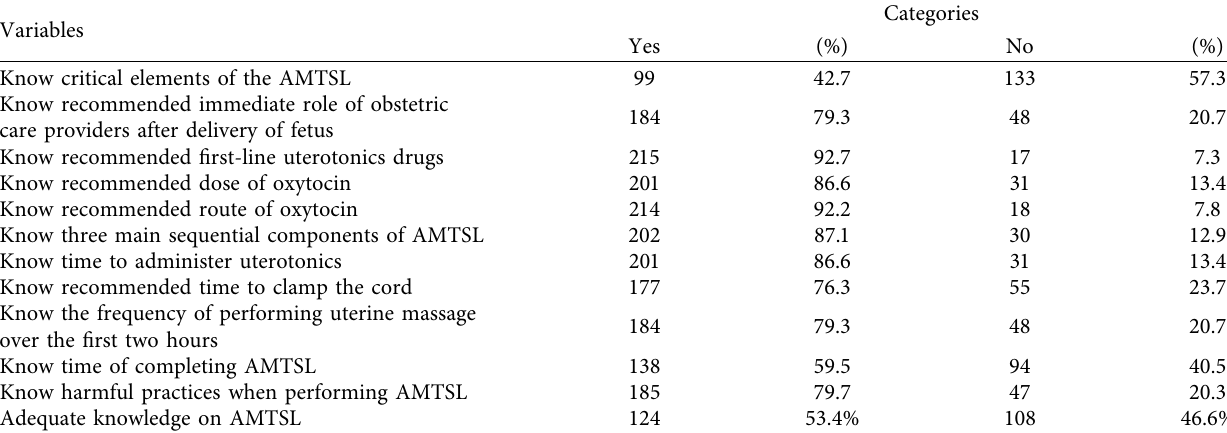
Table 5: Knowledge of obstetric care provider on AMTSL,